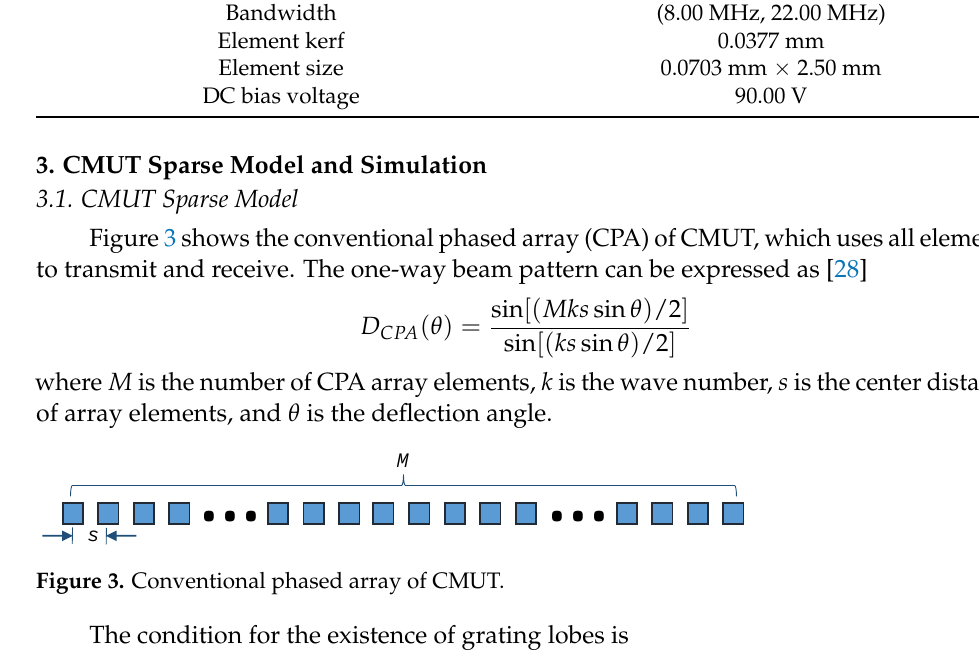
Figure 2. Structure of CMUT linear array. Table 1. Parameters of CMUT linear array (KOLO [29,30], L22-8v).